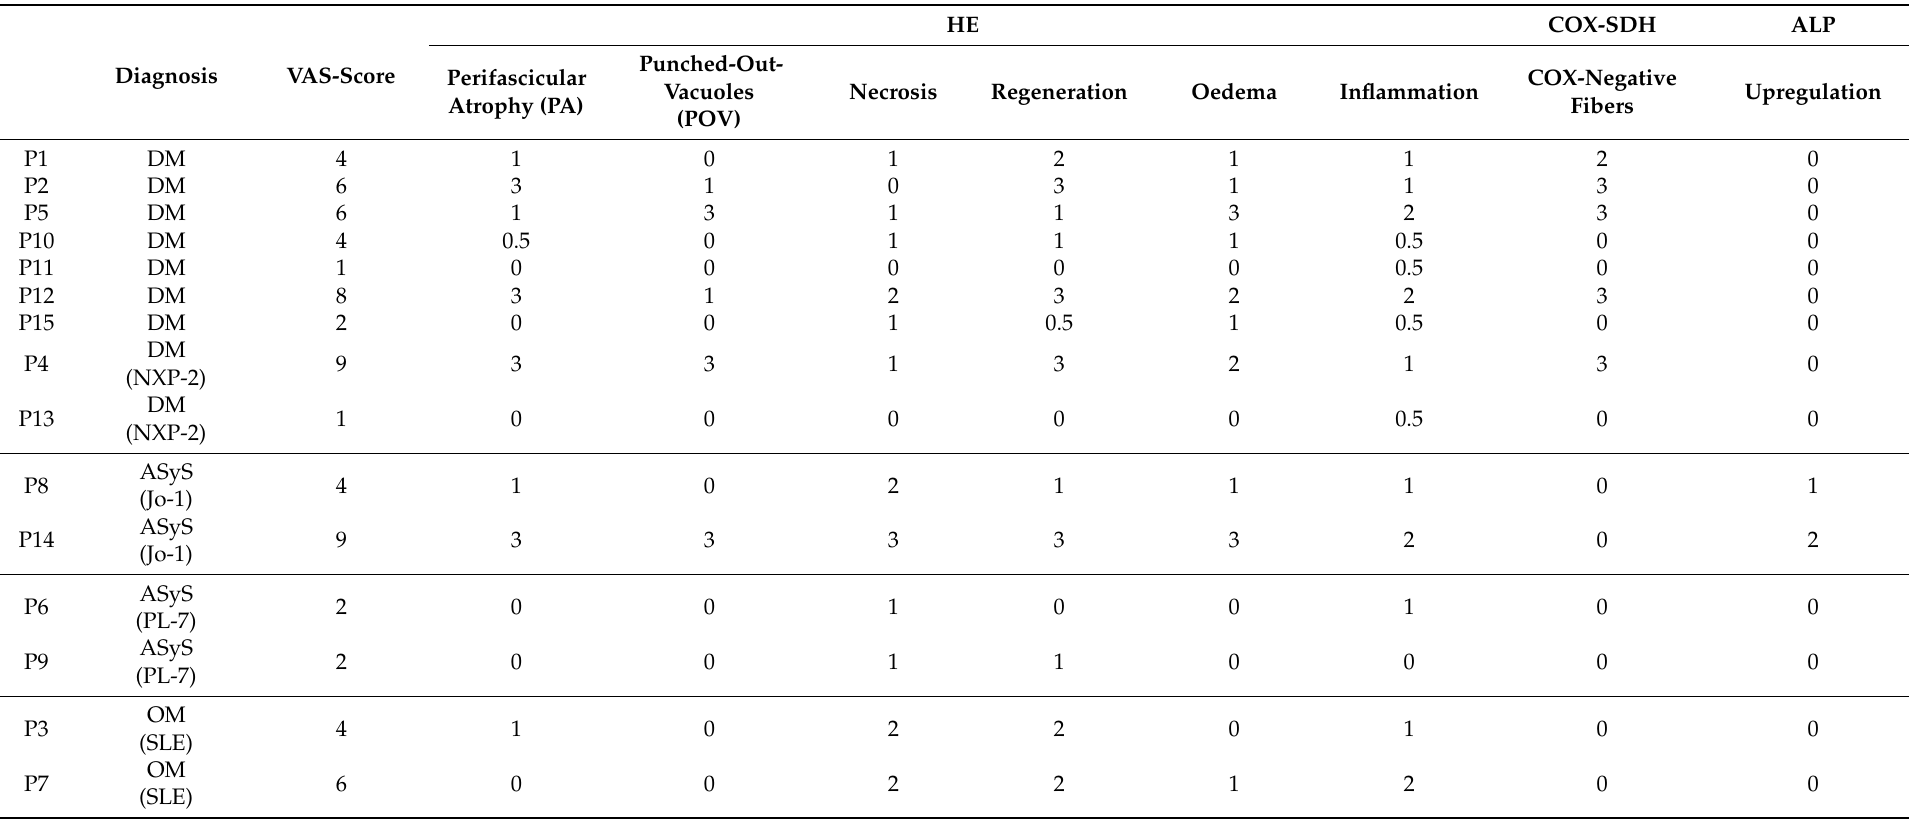
Table A1. Scoring of muscle pathology at standard